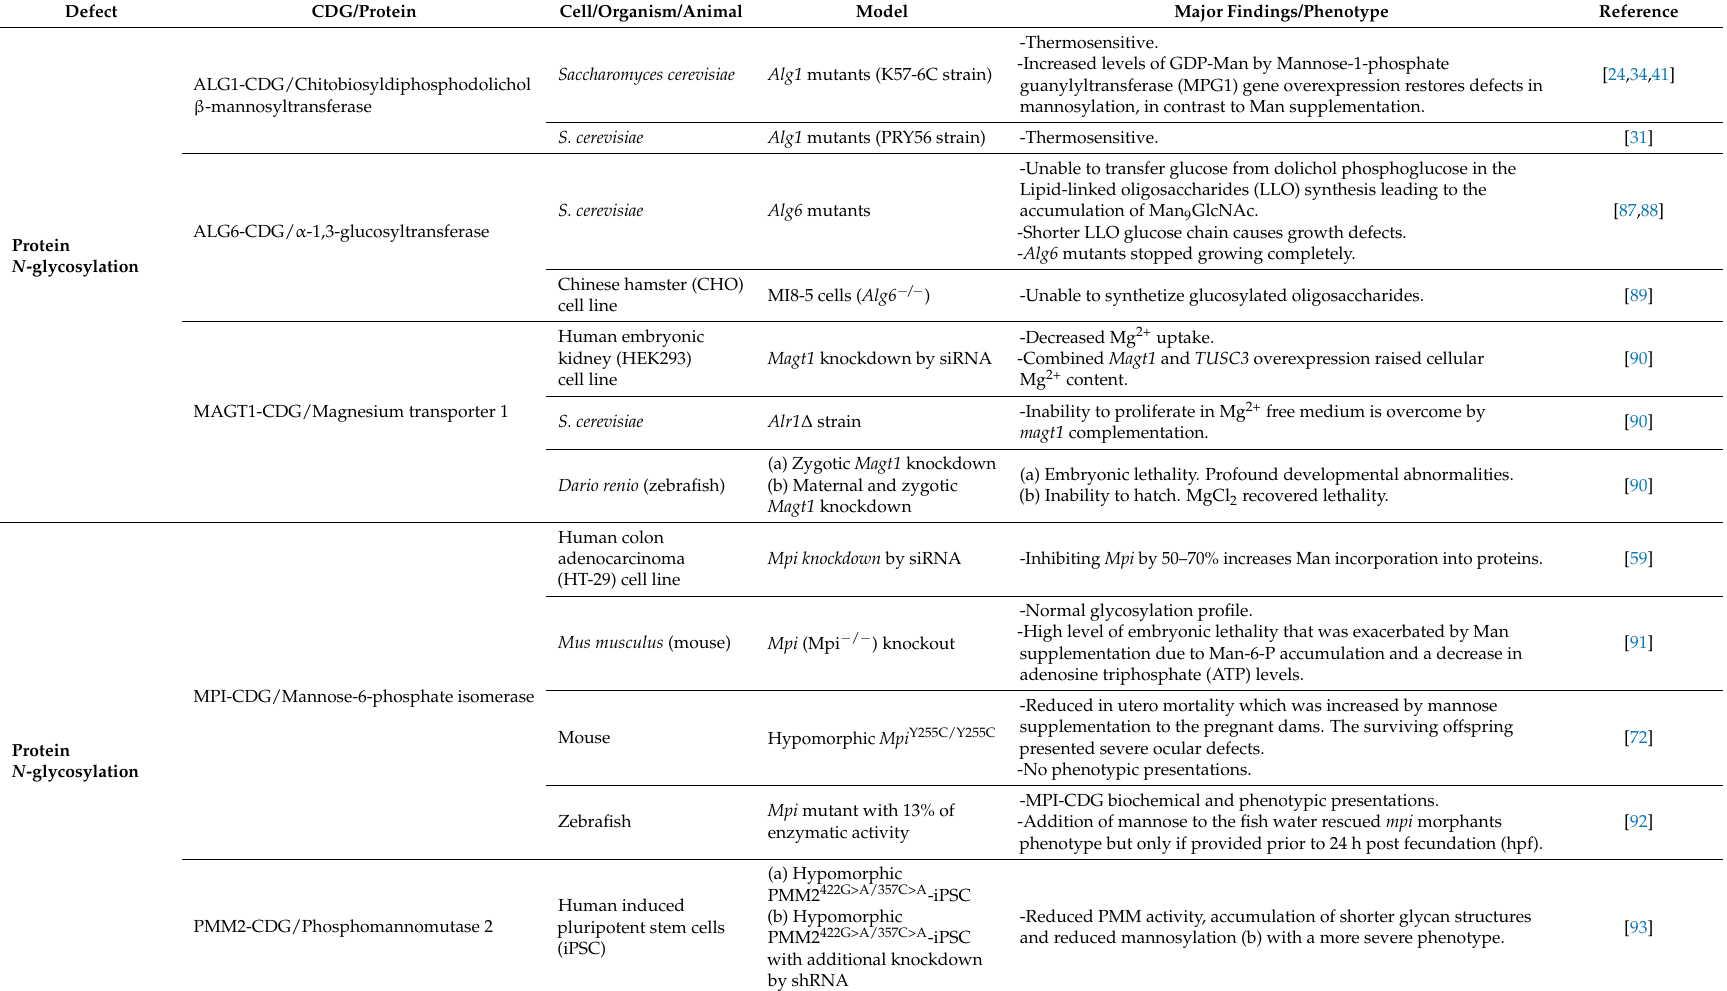
Table 1. Overview of congenital disorders of glycosylation (CDG) disease